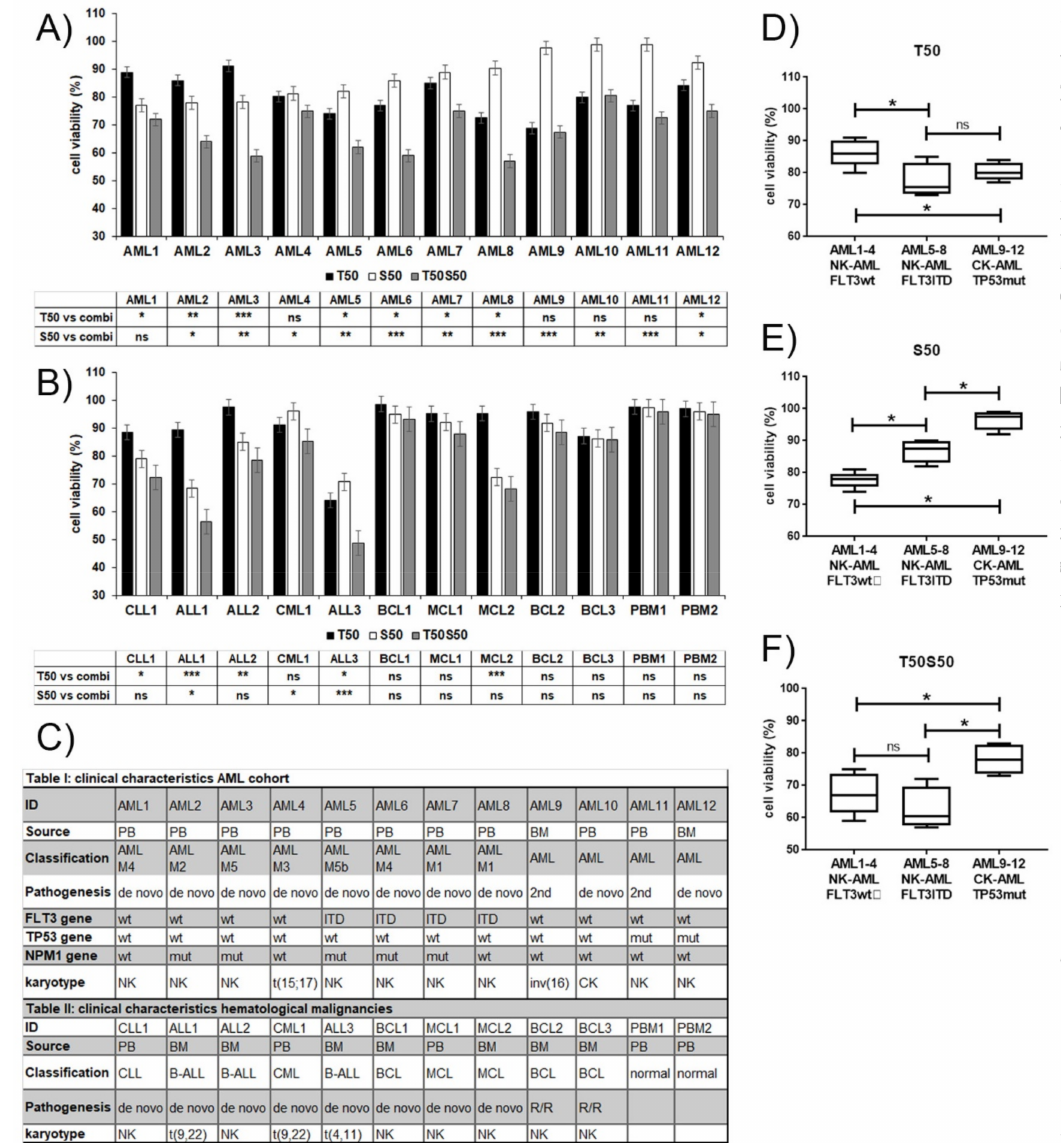
Figure 4. Hematological cells response to S63845, trametinib, and combination treatment. Cell viability assessments in mononuclear cells of AML ( A ), other hematological malignancies ( B ), and normal cells treated for 20 h with S63845 and trametinib alone or in combination. All values are in reference to mock treated cells ( = 100% viability). Statistical significance is indicated for the e ff ects of single versus combination treatments. ( C ) Clinical characteristics of the AML and other hematological malignancies. Acute myeloid leukemia (AML), acute lymphatic leukemia (ALL), chronic lymphatic leukemia (CLL), chronic myeloid leukemia (CML), B-cell lymphoma (BCL), mantle cell lymphoma (MCL). Peripheral blood (PB), bone marrow (BM), normal karyotype (NK), complex karyotype (CK). Relapsed / refractory (R / R). Susceptibility of grouped AML subsets to trametinib ( D ), S638 ( E ), and combination treatment ( F ). Significance is denoted for p < 0.05 (*); p < 0.005 (**); p < 0.0005 (***); p > 0.05